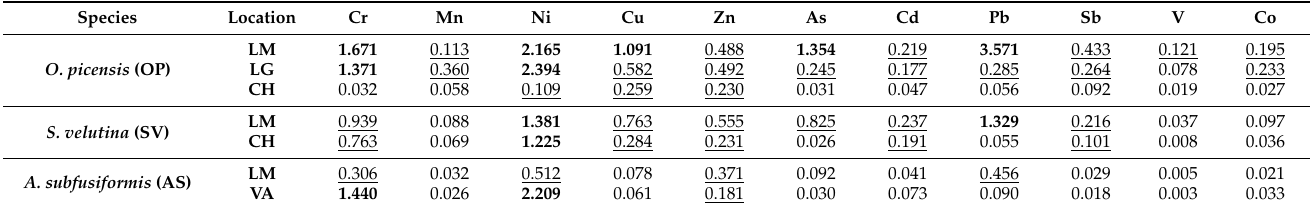
Table 4. Average transfer factor (TF) values of 11 TEs for the plant species collected at the different sampling locations. Los Maitenes (LM), La Greda (LG), Valle Alegre (VA), and yjr reference sampling point at Cachagua (CH). Underlined values indicate medium TF values (0.1–0.9), while those in bold indicate high TF values (>1). Species Location Cr Mn Ni Cu